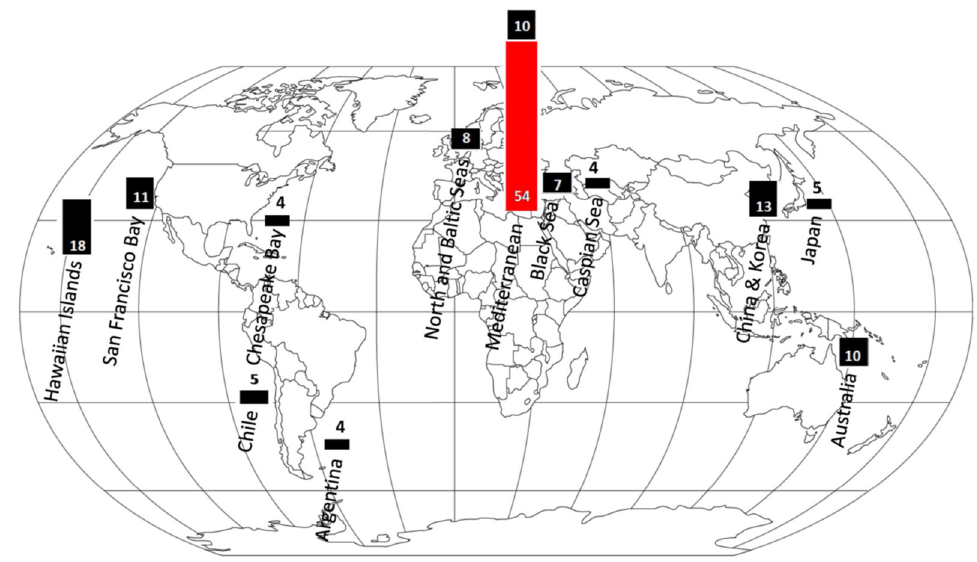
Figure 23. Number of established invasive marine and brackish fish species reported from invasion hotspots (more than four invasive established species). The red histogram denotes Indo-Pacific migrants (adapted from [195]).